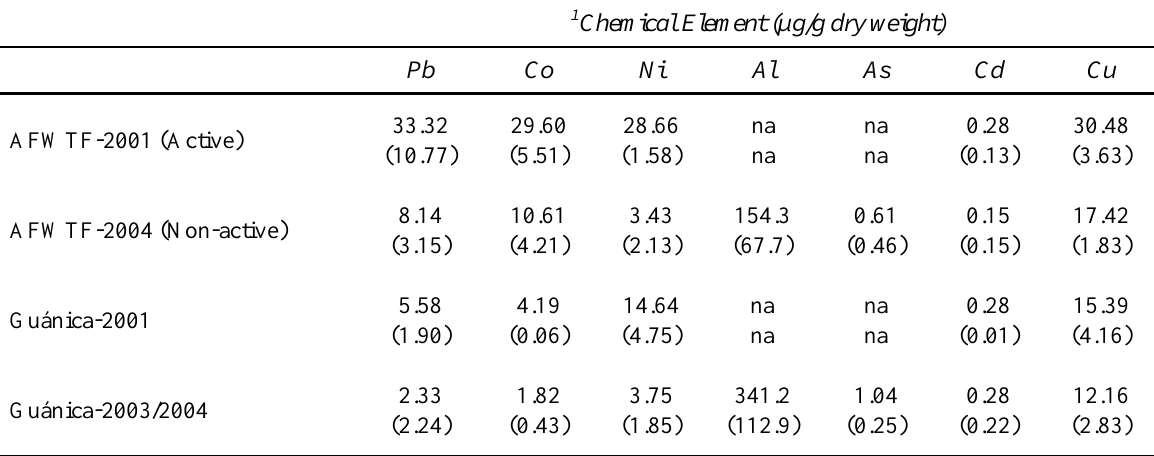
Table 2: Elemental analysis of Syringodium filiforme collected at the AFWTF and Guánica State